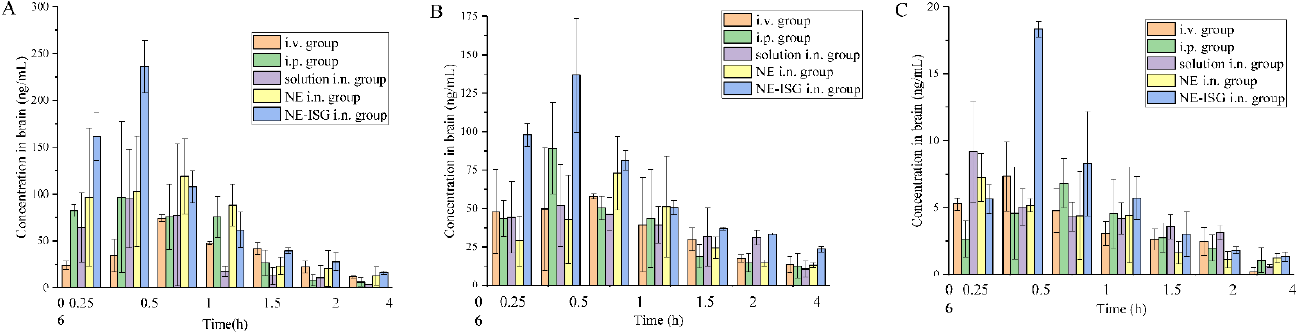
Figure 4. Concentrations of components in brain tissue samples of each group after administration of Chaxiong volatile oil preparation ( n = 3, ⎯ X ± SD). ( A ) Senkyunolide A. ( B ) Neocnidolide. ( C ) n-Butylphthalide.